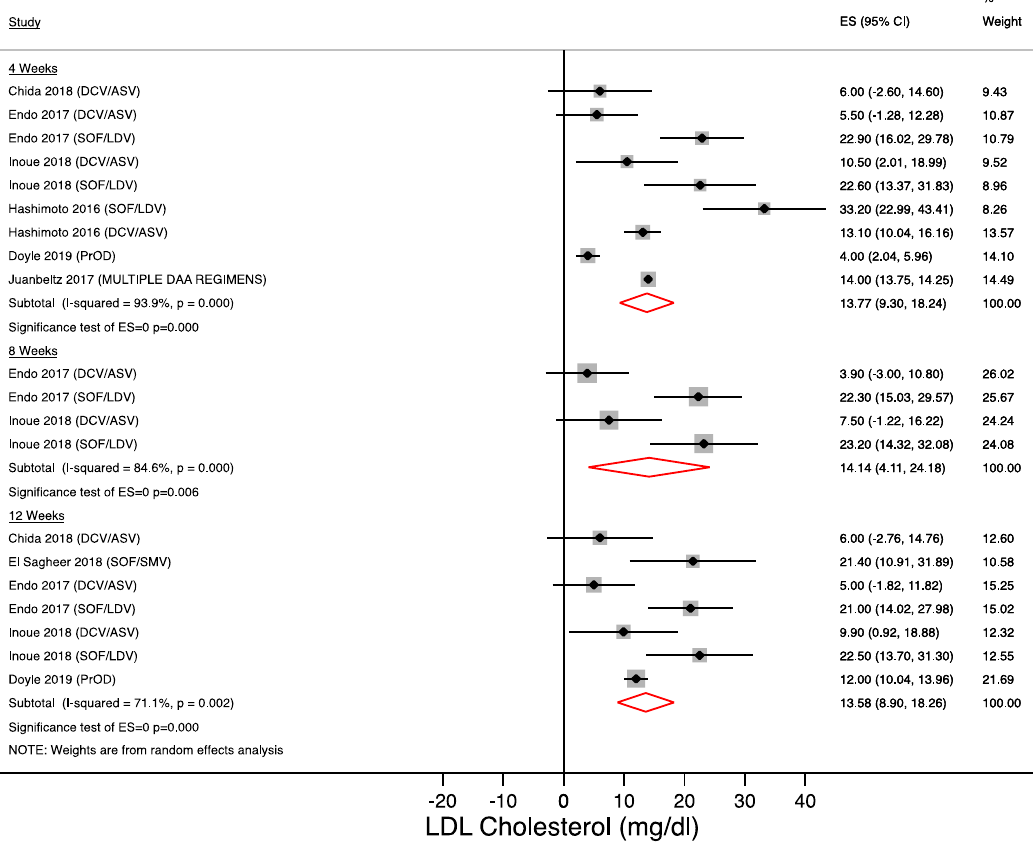
Figure 3. LDL-cholesterol changes during treatment. Forest plot for mean difference (MD) and 95% confidence intervals (CI) for each time-point. DCV/ASV daclatasvir/asunaprevir, SOF/LDV sofosbuvir/ledipasvir, SOF/RBV sofosbuvir + ribavirin, SOF/SMV sofosbuvir/simeprevir, GRZ/EBV